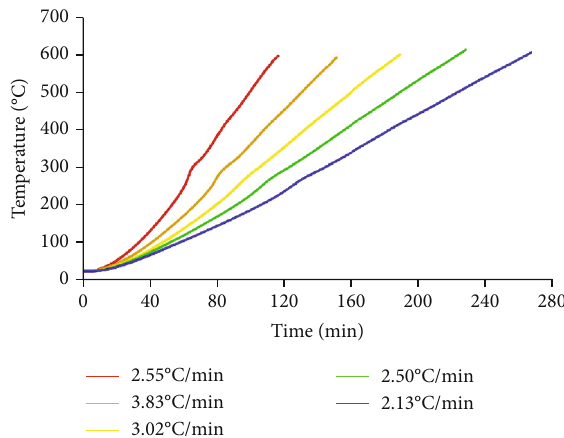
Figure 3: Temperature history for kinetic cell (RTO) experiments with di ff erent heating rates. Table 1: H/C ratio ( n ) and CO/CO kinetic cell (RTO) experiments.